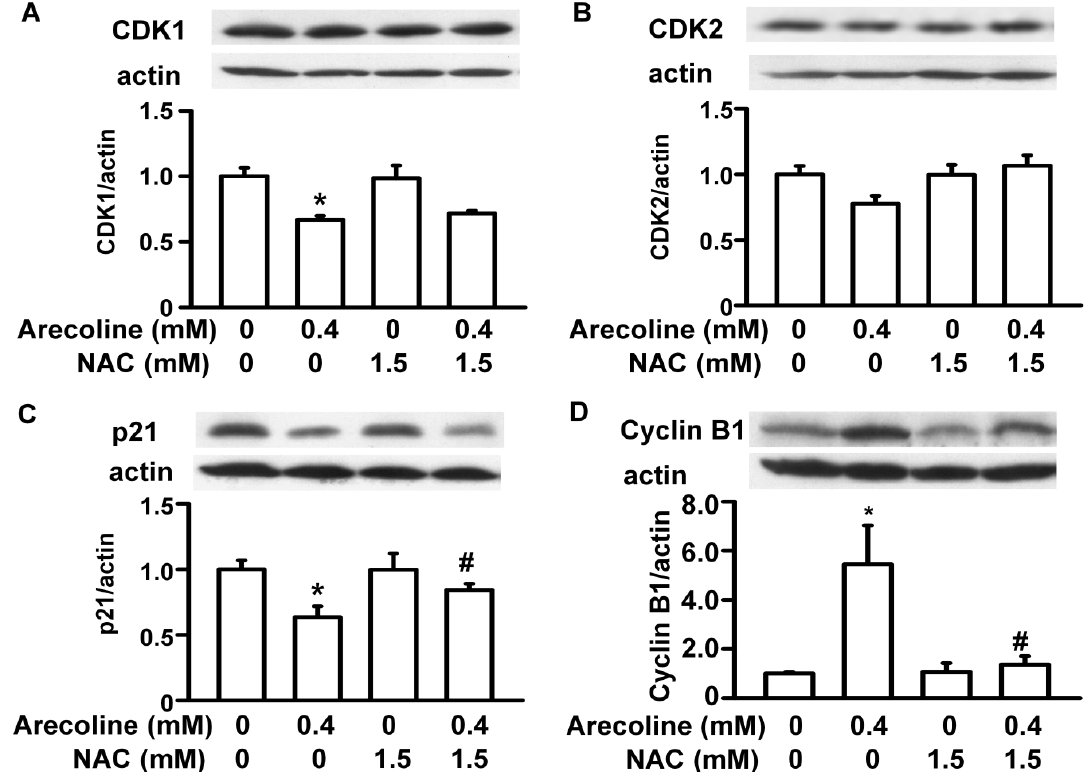
Figure 9. N-acetylcysteine (NAC) blocked the arecoline-induced alterations in the levels of cell cycle regulatory proteins, such as CDK1( A ), CDK2( B ), p21( C ) and Cyclin B1( D ), in androgen-independent human PC-3 prostate cancer cells. Cells were pretreated with NAC for 1 h and then exposed to 0.4 mM arecoline. After 24 h of treatment, proteins were examined by Western blot analysis and then expressed after normalization to actin expression. Data are expressed as the mean ± SEM from triplicate experiments; each result was pooled from the data of four 10 cm culture plates. * p < 0.05 vs. the control; # p < 0.05 arecoline vs. NAC + arecoline.